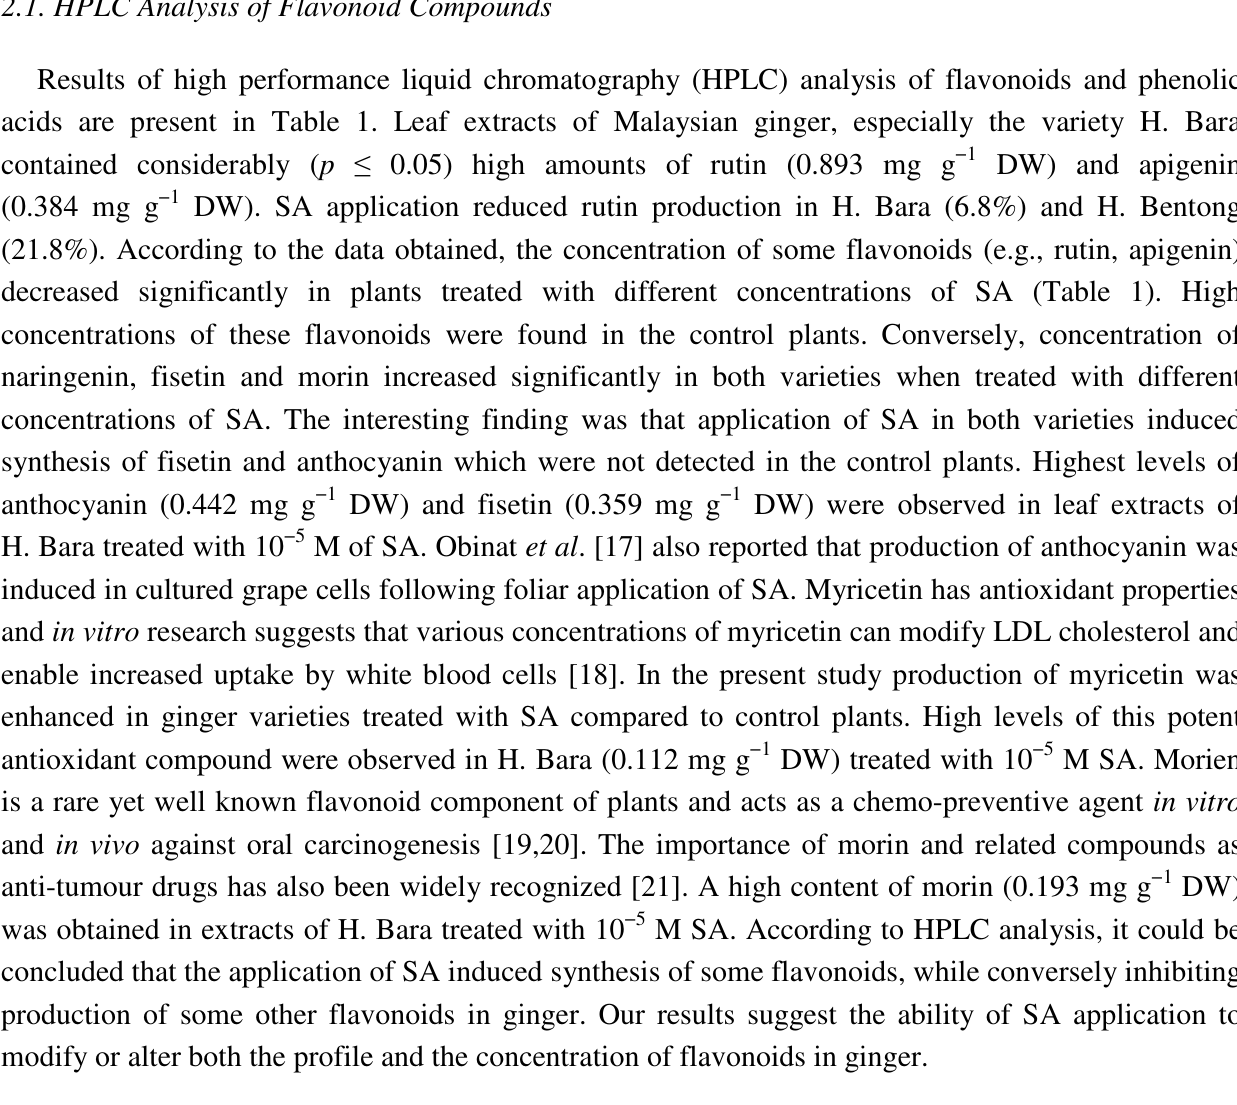
Table 1. High performance liquid chromatography analysis of ginger ( Zingiber officinale ) varieties treated with salicylic acid